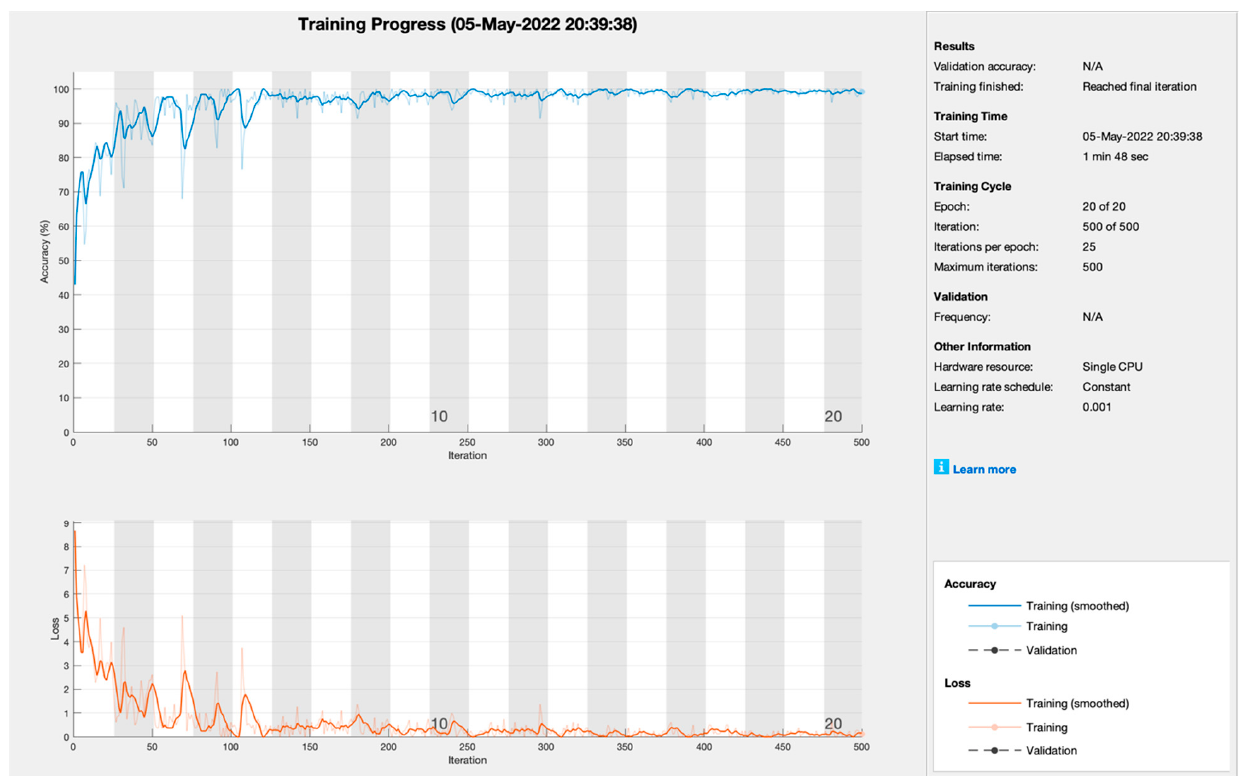
Figure 6. Training progress of RMSPROP empowered with AlexNet to predict kidney cancer.